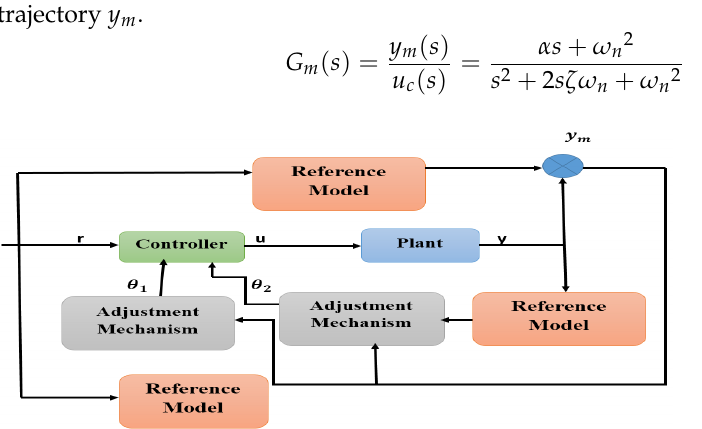
Figure 10. MRAC System with MIT Rules.